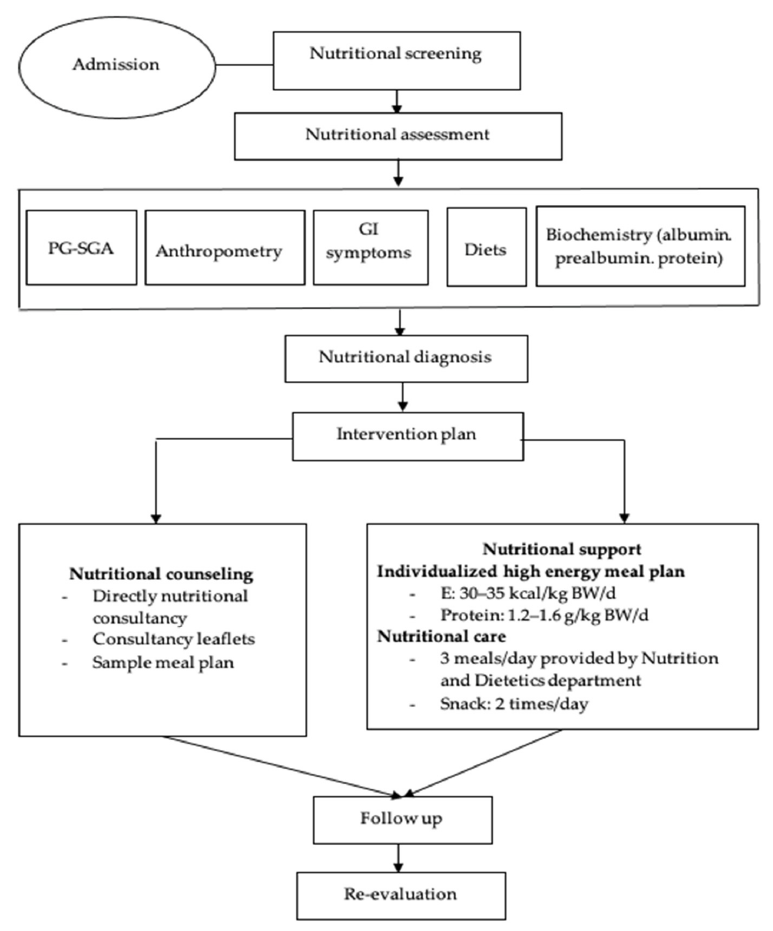
Figure 2. The process diagram of nutritional intervention for intervention